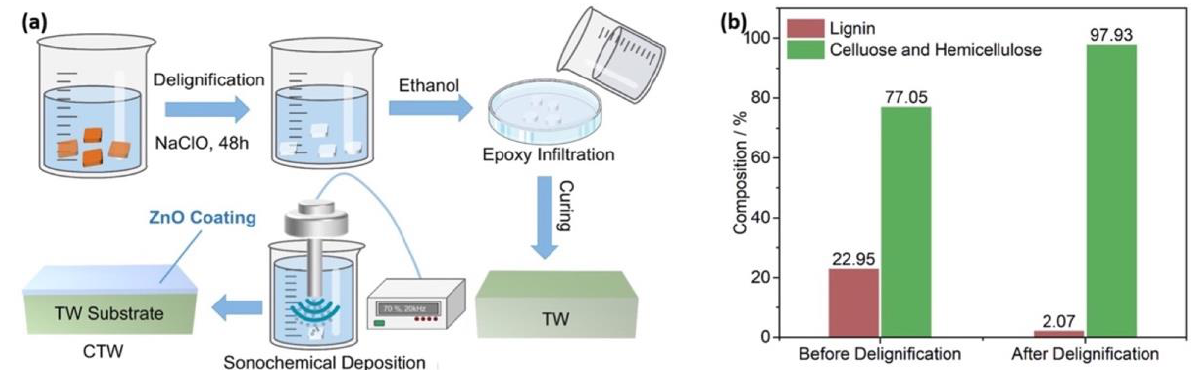
Figure 24. ( a ) Schematic manufacturing procedures of coated transparent wood (CTW); ( b ) chemical compositions of balsa wood before and after delignification. Reprinted with permission from [42], copyright 2022, Elsevier.